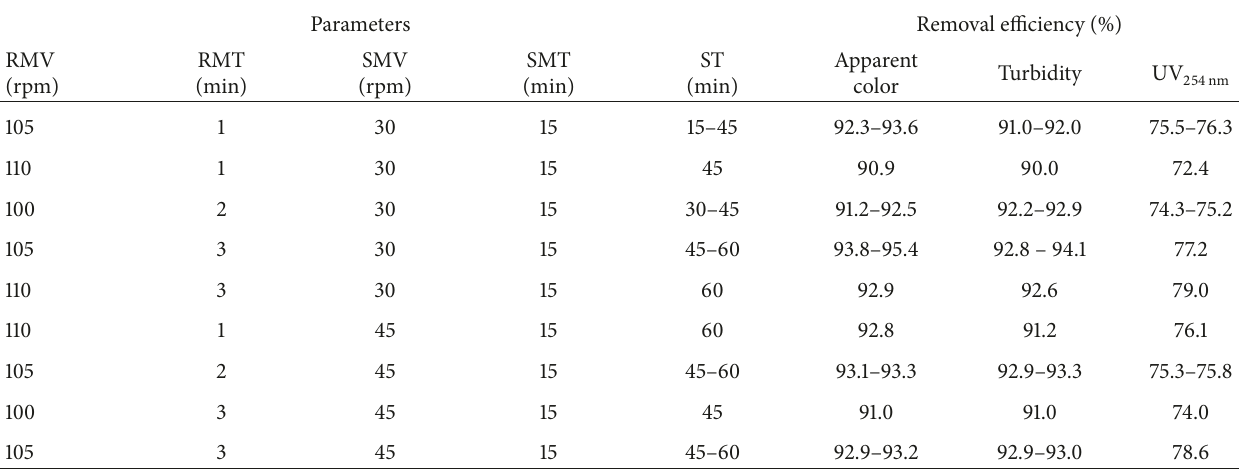
Table 4: Values of removal efficiency for the best operating conditions in association of seeds of M. oleifera and aluminium sulphate.